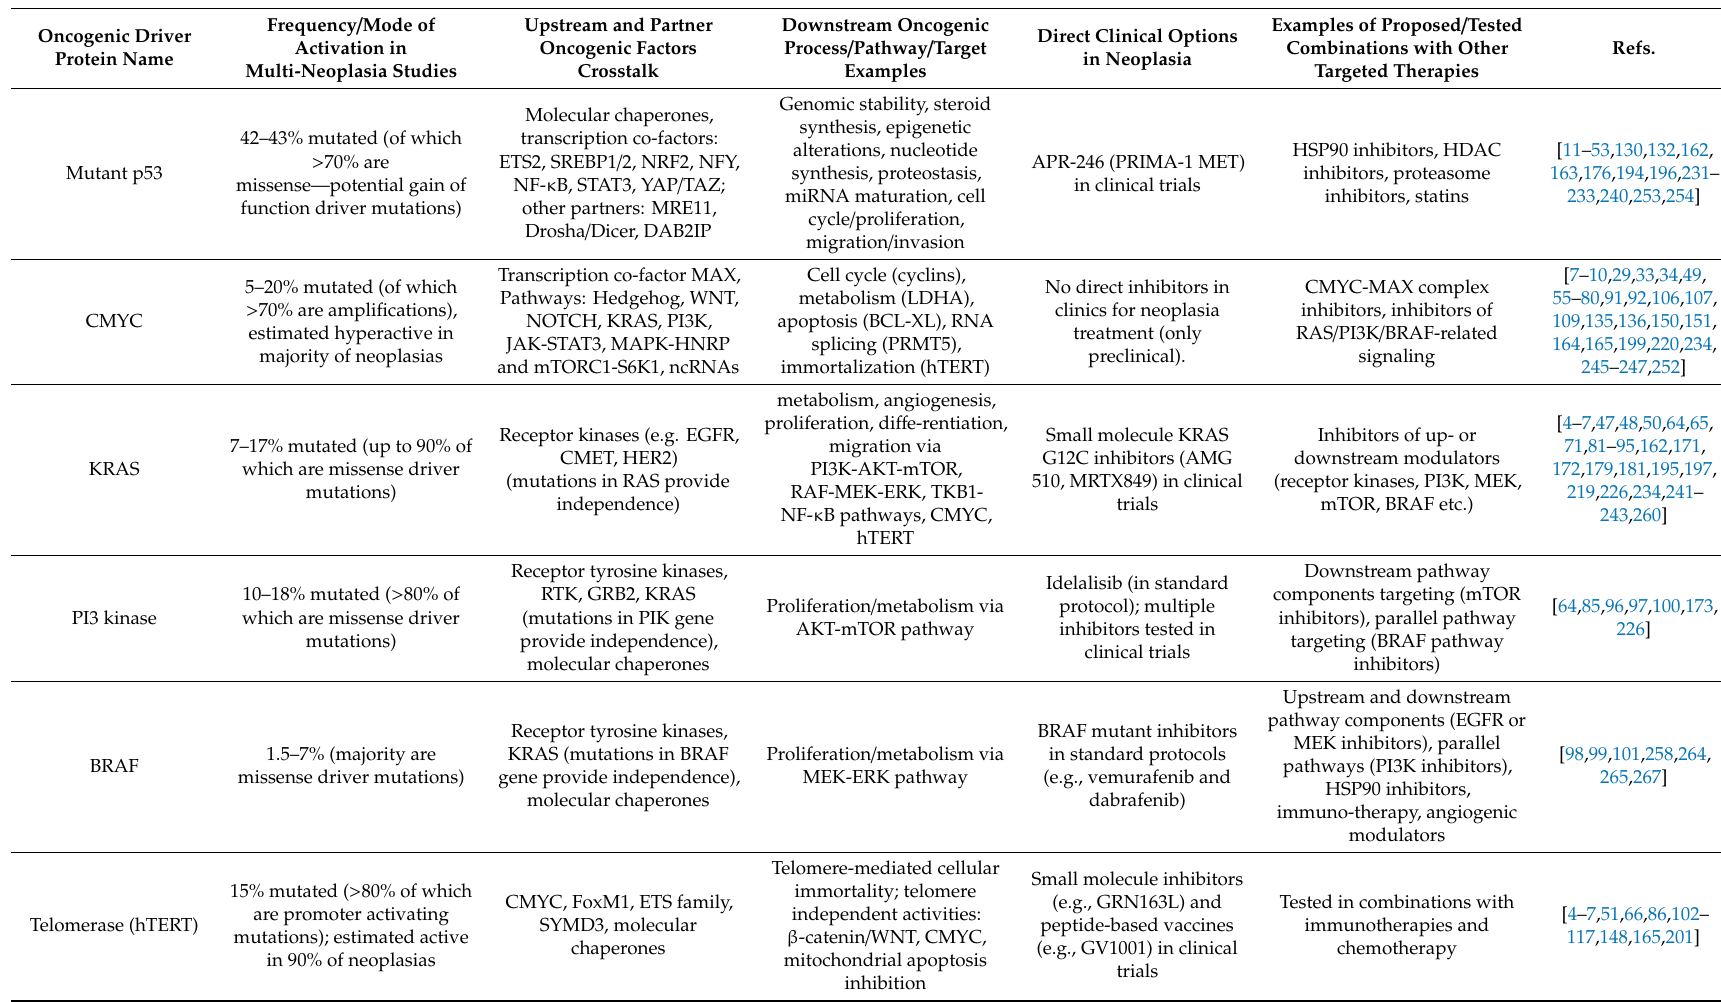
Table 1. Upstream and downstream interplays of the universal oncogenic drivers described in the text along with the current and proposed therapeutic solutions. Oncogenic Driver Protein